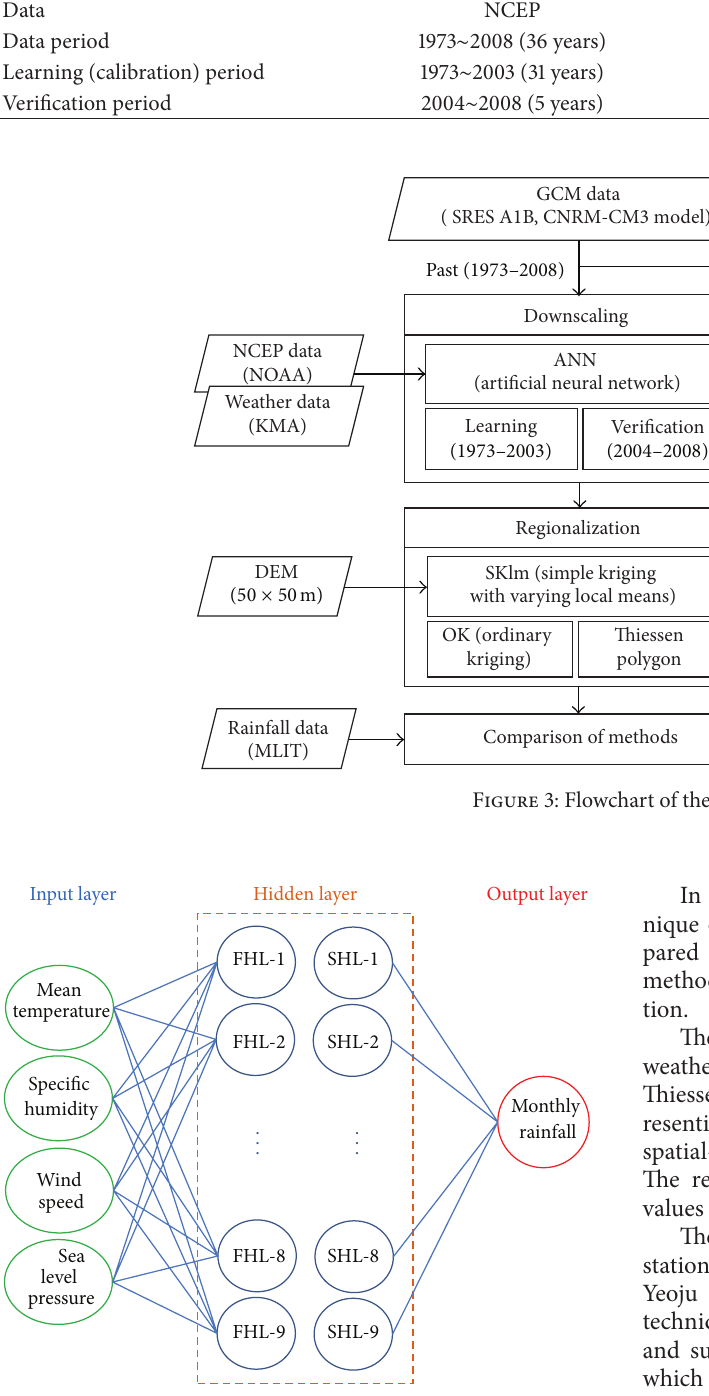
Figure 4: Construction of ANN model.